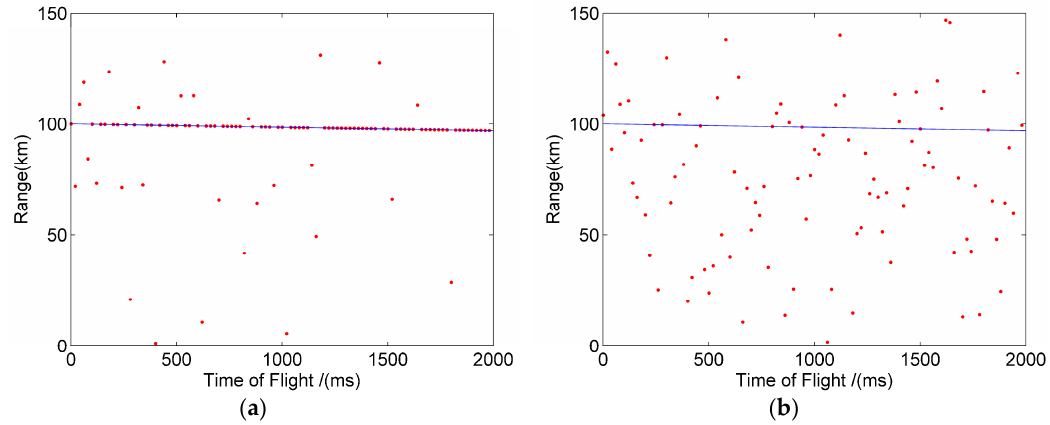
Figure 7. Target trajectory of the simulation. ( a ) Macro pulse method. ( b ) Pulse accumulation method.